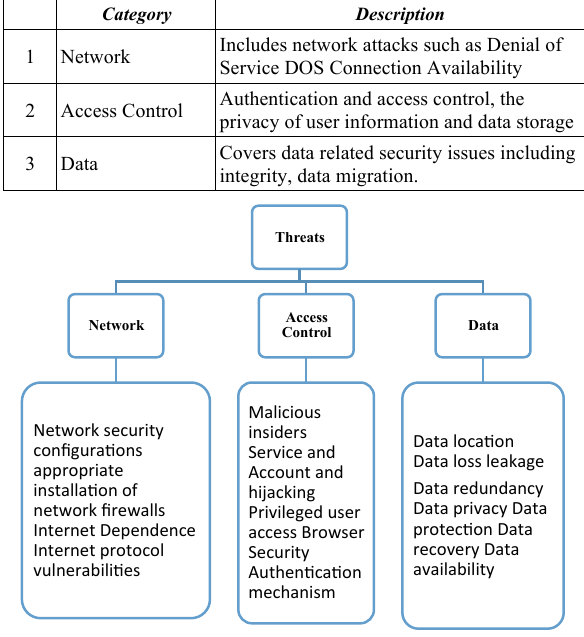
Figure 2. Cloud security issues and classifications [Rola, et.al., 2016][34]